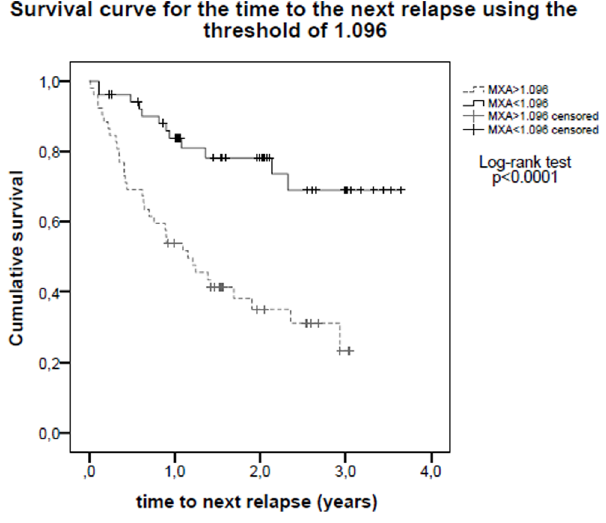
Figure 1. Survival curve for the time to the next relapse using the 1.096 threshold. Patients belonging to the low-MxA group (MxA , 1.096) showed a significantly longer time to the next relapse (p , 0.0001).